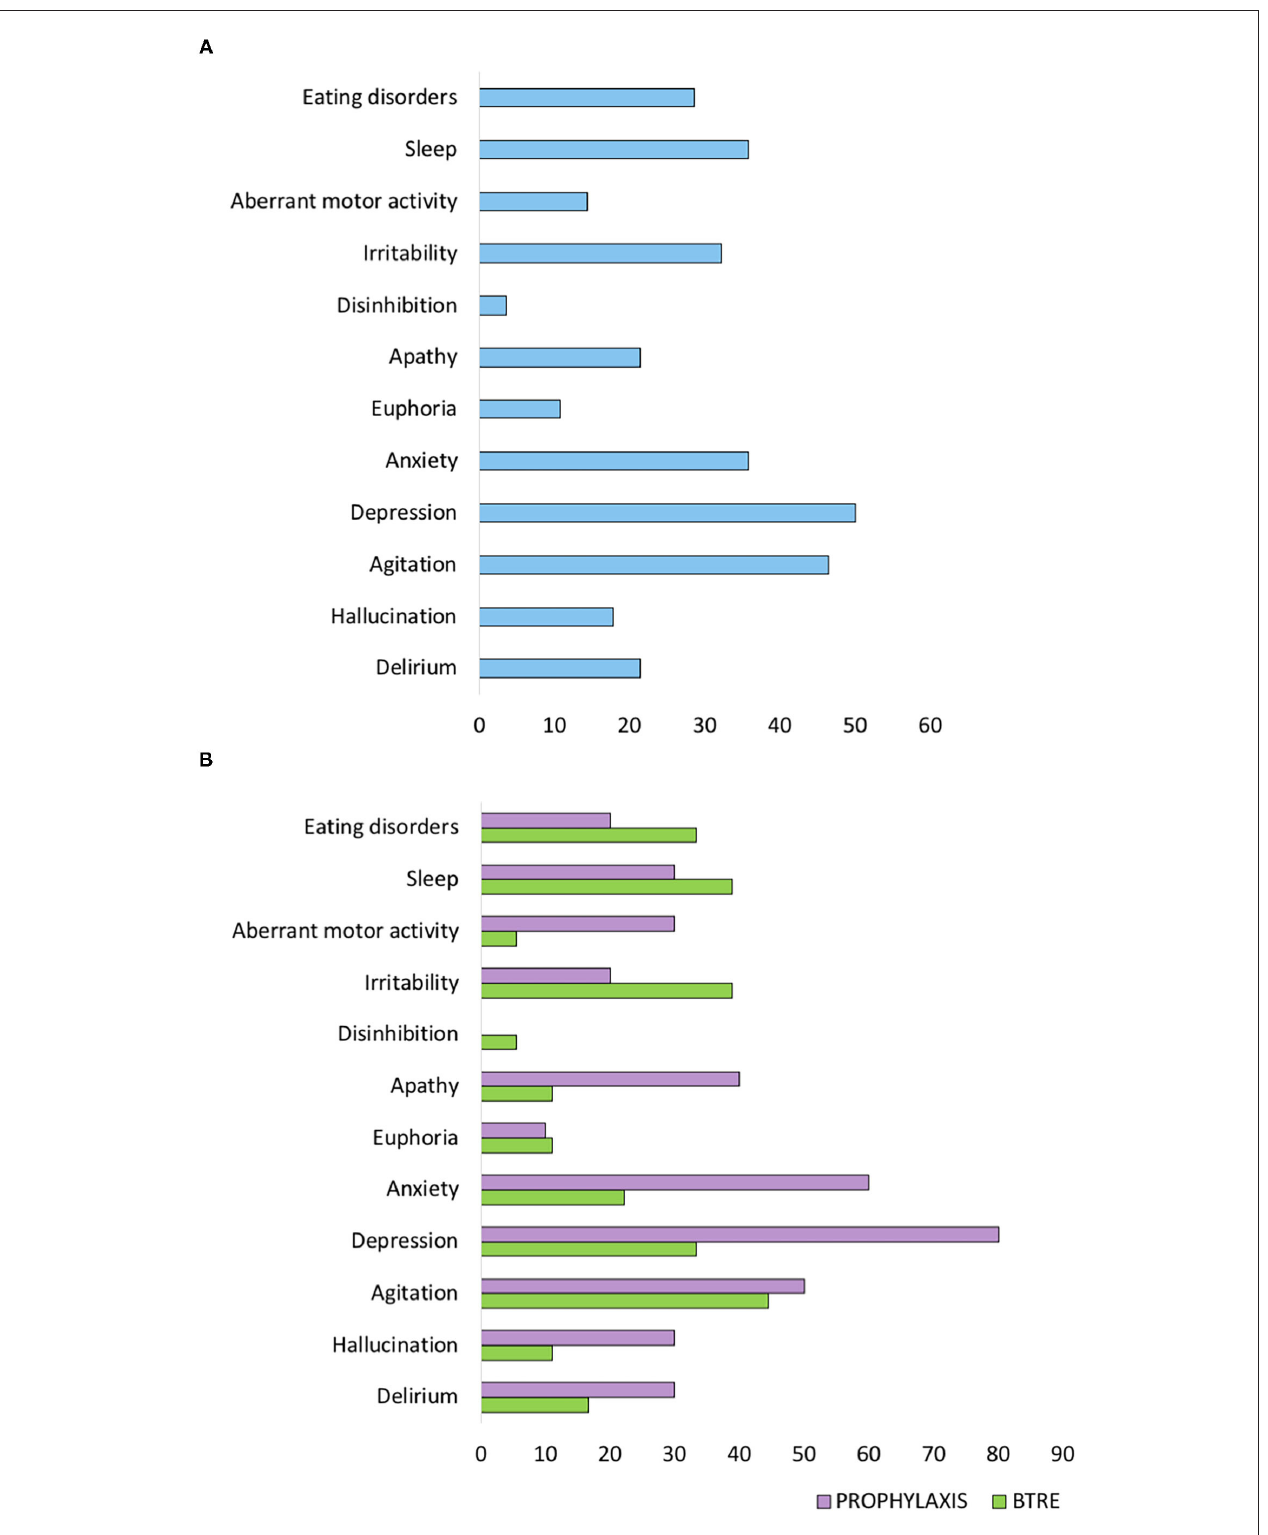
FIGURE 1 | Neuropsychiatric Inventory (NPI-Q) scale score at 12 months follow-up visit. (A) NPI-Q sub-items scores of the entire study population. (B) NPI-Q sub-items scores of the two subgroups.